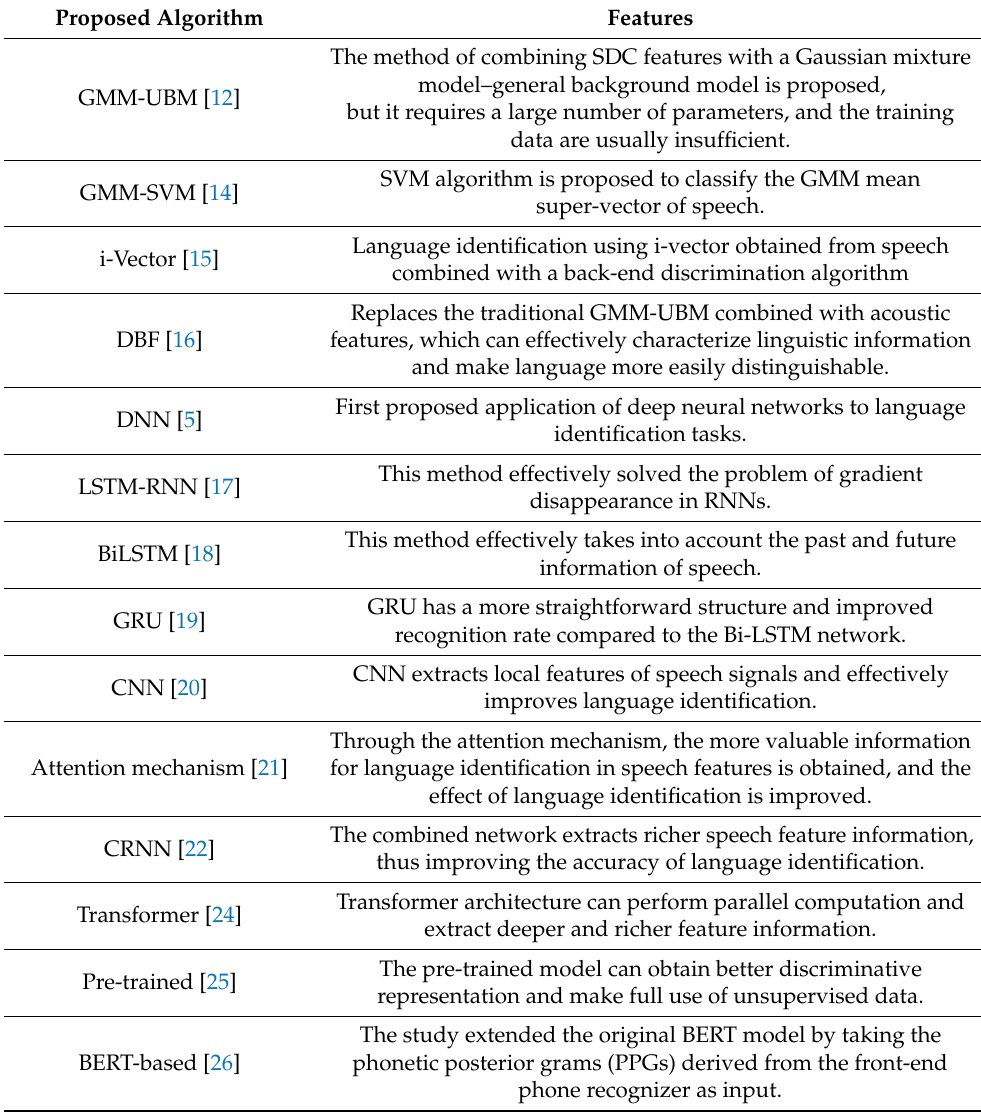
Table 1. Characteristics of different language identification